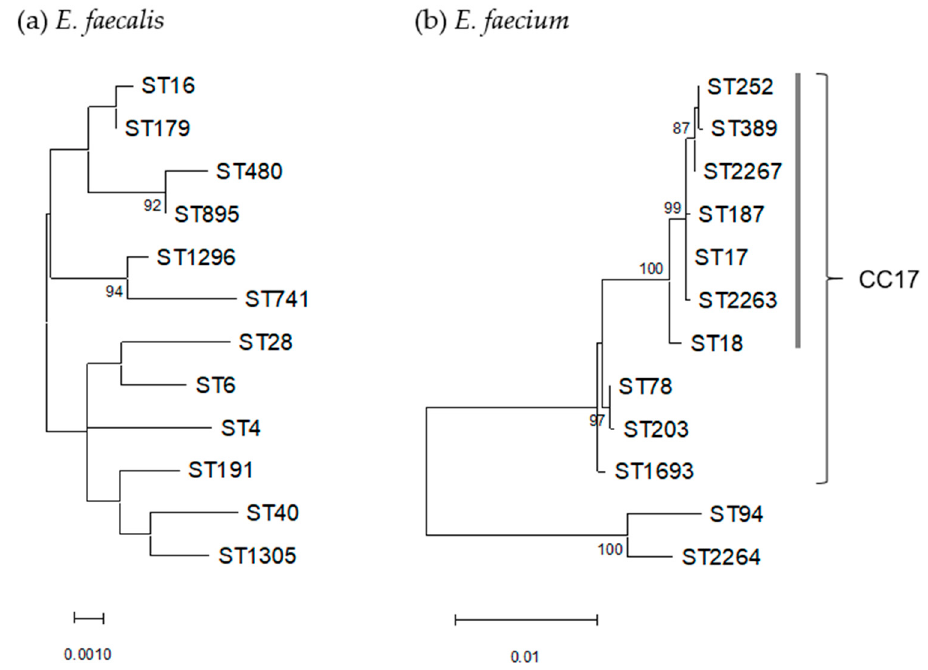
Figure 2. Phylogenetic trees based on concatenated sequences of seven MLST loci of 12 STs each of E. faecalis ( a ) and E. faecium ( b ). Dendrogram was constructed by maximum-likelihood method with the MEGA11 program and statistically supported by bootstrapping with 1000 replicates, and genetic distances were calculated by the Kimura two-parameter model. Variation scale is shown at the bottom. Percent bootstrap support is indicated by the values at each node (the values <80 are omitted). A cluster of E. faecium containing ST17 within CC17 is shown by a vertical bar on the right. Nearly all the E. faecium (96%, n = 52) were assigned to CC17, which consisted